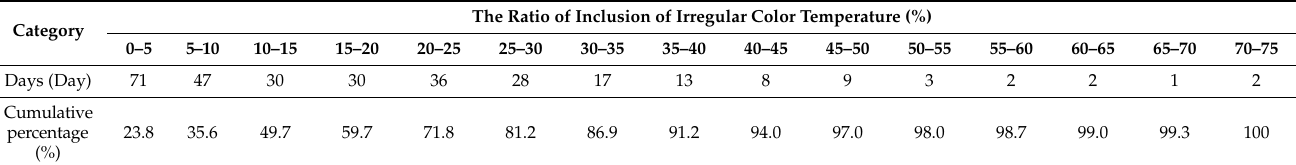
Table 1. The ratio of anomaly inclusion in the daily measured natural light color temperature. The Ratio of Inclusion of Irregular Color Temperature (%)